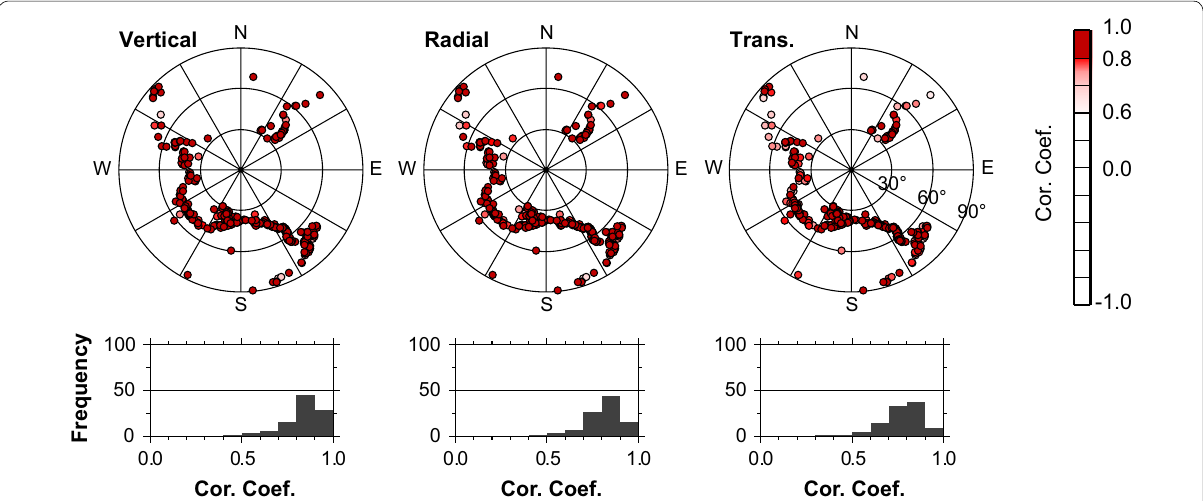
Fig. 3 Distributions of cross-correlation coefficients for long-wavelength teleseismic waveforms. Distributions of cross-correlation coefficients (CCs) between the teleseismic waveforms observed at N.WTRF and N.WATH. A low-pass filter of 0.15 Hz was applied to the seismograms. ( Upper ) Azimuthal distribution of CCs. Radius corresponds to the epicentral distance of each event. Color depth corresponds to the CC. ( Lower ) Histograms of CCs. Only the positive coefficient range is displayed because no negative values were detected